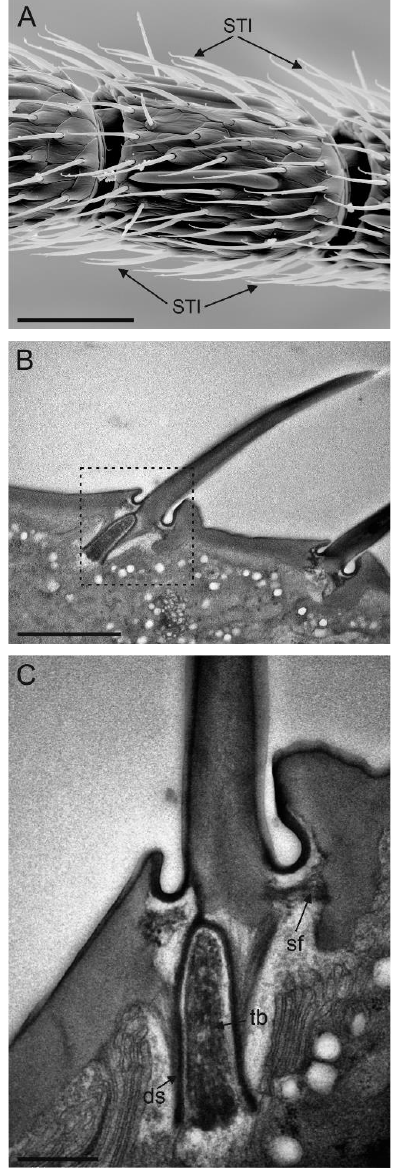
Figure 4. ( A ) SEM picture of flagellomere 5 (F5) of Anagyrus vladimiri female antennae showing the distribution of sensilla trichoidea I (ST I). ( B ) TEM picture taken longitudinally through the cuticular shaft and base socket. ( C ) Close-up view of the base socket (dotted square in ( B ) showing the suspension fibres and the single sensory neuron ending in a tubular body (tb) encased by the dendrite sheath (DS). Scale bar: ( A ): 30 µm; ( B ): 2µm; ( C ): 0.5 µm.